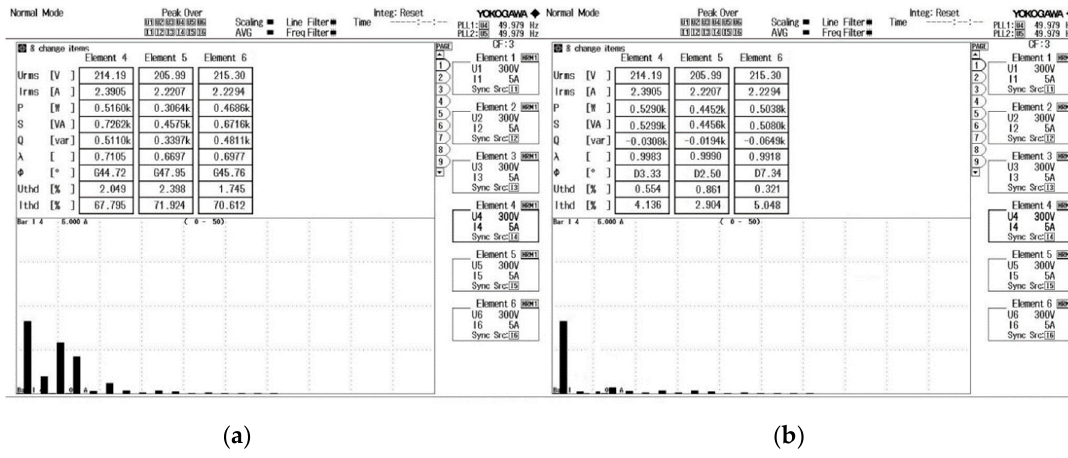
Figure 16. FFT Spectrum of source current ( a ) before compensation and ( b ) after compensation.